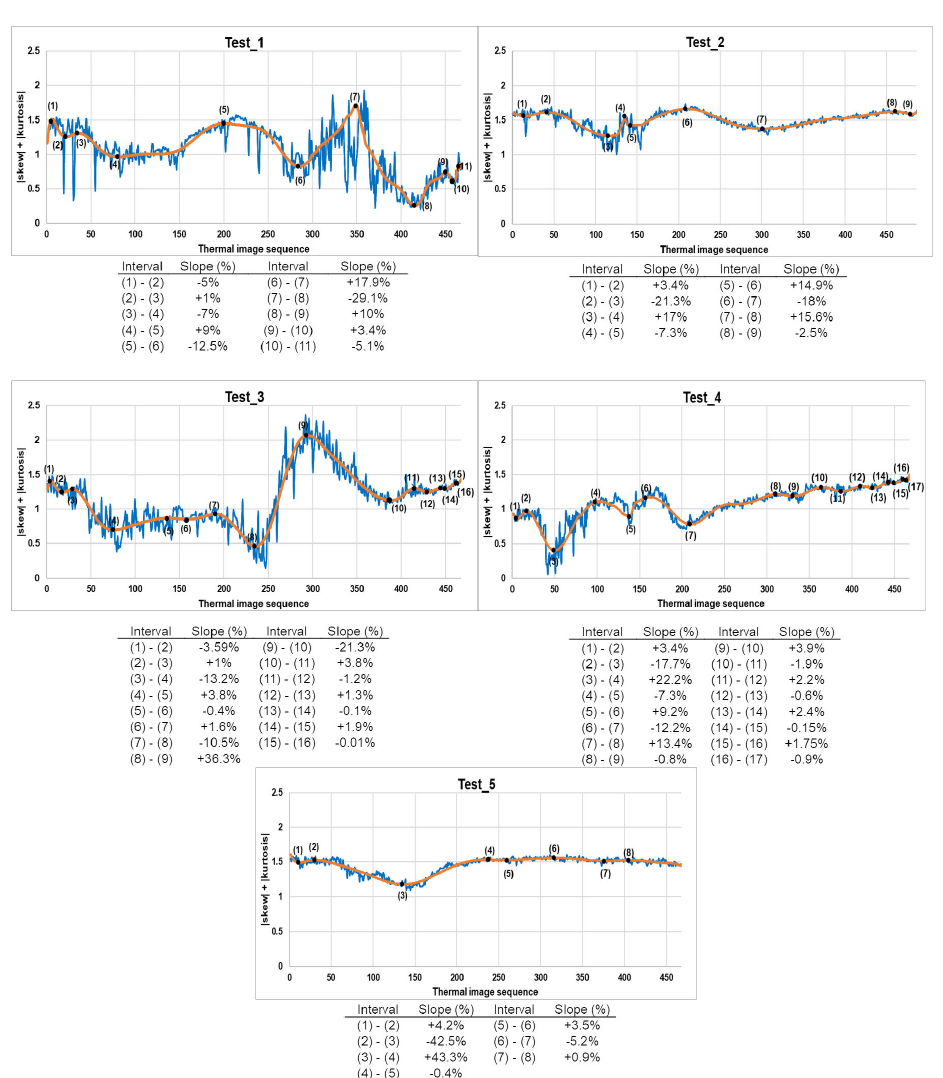
Figure 6. Relative maximums and minimums obtained (numbers indicated in the graph) and slope calculation (table below the graph) following the evolution of each test performed after SG smoothing filter application (orange line). Blue lines indicate the evolutions of the tests performed before SG smoothing filter